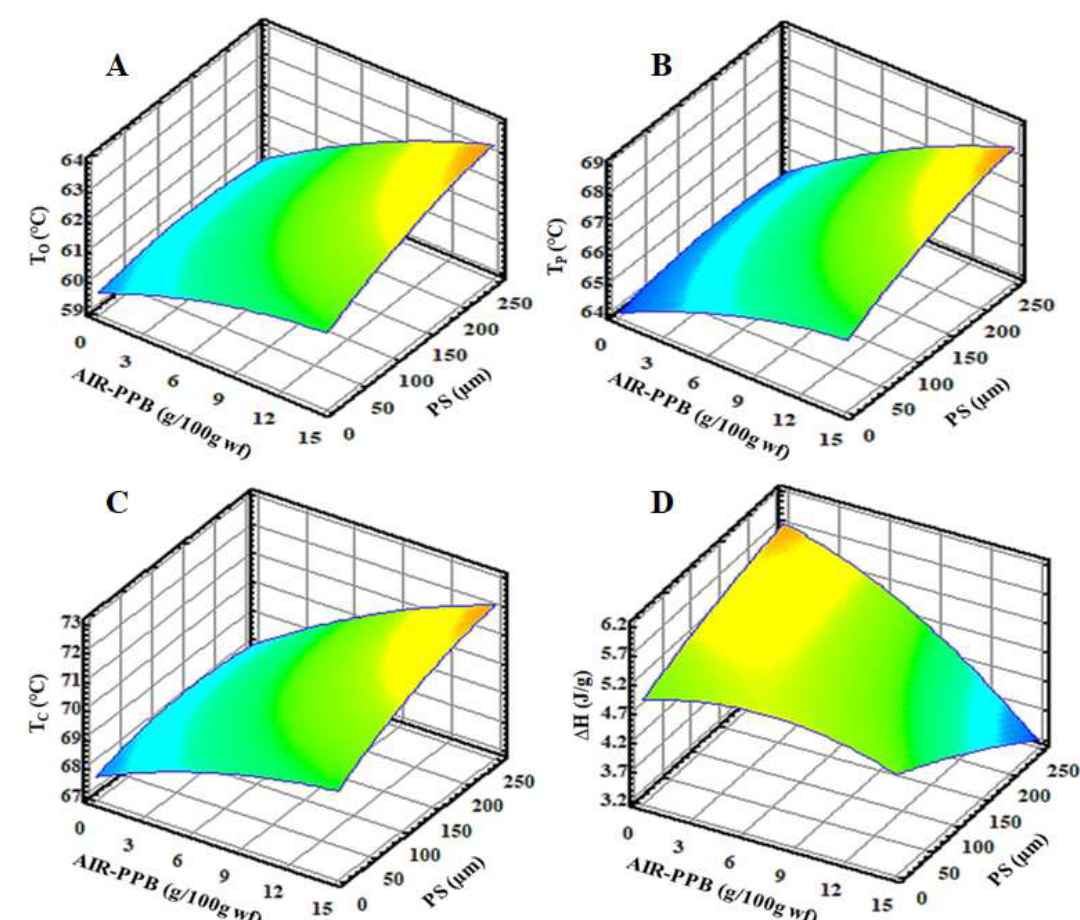
Figure 3. Response surface plots of the interaction of alcohol insoluble residue from potato peel byproduct (AIR-PPB) and particle size (PS) on ( A ) onset temperature (To) ( ◦ C), ( B ) melting temperature (Tp) ( ◦ C), ( C ) conclusion temperature (Tc) ( ◦ C), and ( D ) ∆ H (J/g) of fiber-enriched pasta (FEP) samples.